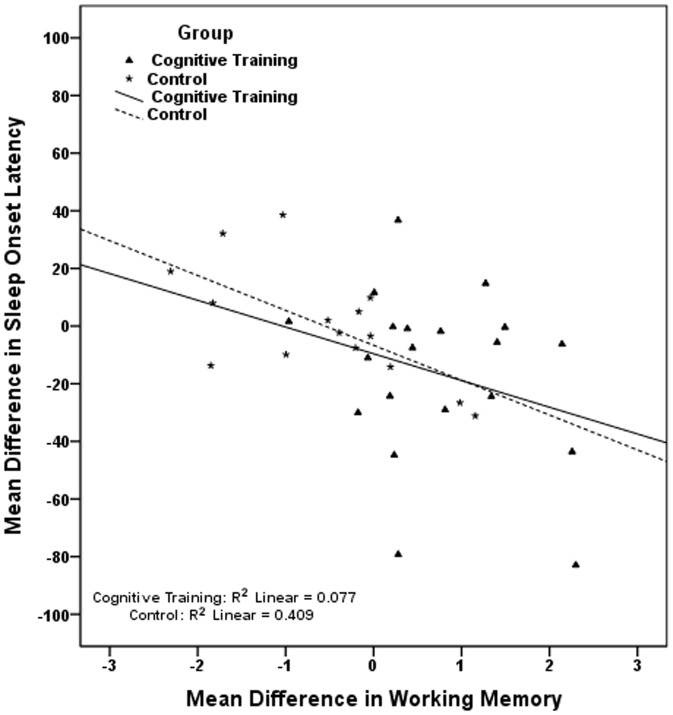
Linear regression between Mean Difference (post-intervention mean minus baseline mean) in Sleep Onset Latency (dependent) and Mean Difference (post-intervention mean minus baseline mean) in Working Memory (independent).